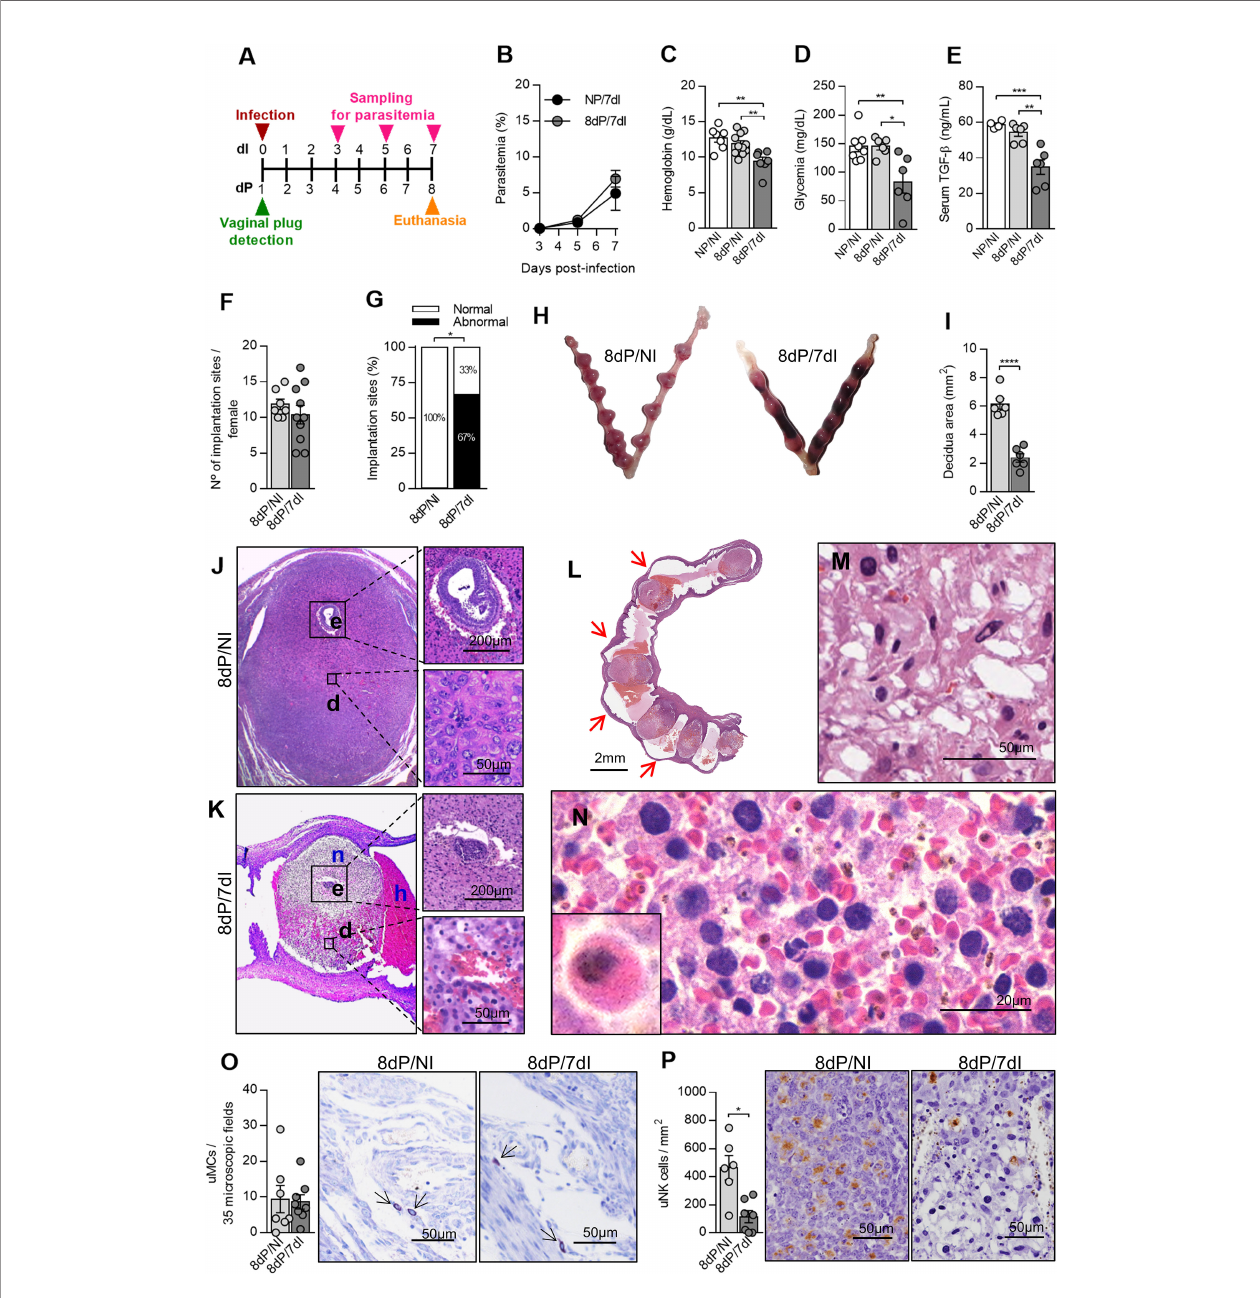
FIGURE 1 | Plasmodium berghei ANKA infection causes poor pregnancy outcome during early pregnancy. (A) An experimental design for the study of malaria in early gestation using BALB/c mice infected with P. berghei ANKA was performed. (B) Parasitemia levels were estimated by fl ow cytometry (n = 5 mice/group). (C – E) Hemoglobin (NP/NI, n=7; 8dP/NI, n=11; 8dP/7dI n=7), blood glucose (NP/NI, n=8; 8dP/NI, n=6; 8dP/7dI, n=6) and serum TGF- b levels were measured (NP/NI, n=4; 8dP/NI, n=6; 8dP/7dI, n=6). (F – H) The number of implantations sites per female was counted (8dP/NI, n=7; 8dP/7dI, n=10) (F) and classi fi ed as normal or abnormal (G) according to macroscopic aspect (H) (8dP/NI, n=7; 8dP/7dI, n=10). (I-N) Uterine tissue was histologically processed and tissue sections were stained by H&E. Decidual area was delimited (I) and implantation sites of uninfected (J) and infected mice (K) were evaluated. e, embryo; d, decidua; n, necrosis; h, hemorrhage. Most of the infected mice presented intrauterine hemorrhages, which are indicated by red arrows (L) , decidual edema (M) and decidual hemorrhage, where infected red blood cells were frequently observed (N). (O) uMCs were detected and quanti fi ed in Toluidine Blue stained implantation sites (8dP/NI, n=7; 8dP/7dI, n=8). (P) uNK cells were detected and quanti fi ed in DBA lectin-stained implantation sites (8dP/NI, n=6; 8dP/7dI, n=7). Results represent mean ± SEM. Data was analyzed by Two-way ANOVA followed by Bonferroni ’ s post-test (B) , One-way ANOVA with Bonferroni ’ s post-hoc comparisons tests (C – E) , unpaired t-test (F, I, O, P) or Mann-Whitney test (G) . NP, non-pregnant, NI, non-infected, dP, days of pregnancy, dI, days of infection. *: p <0.05; **: p <0.01; ***: p <0.001; ****: p